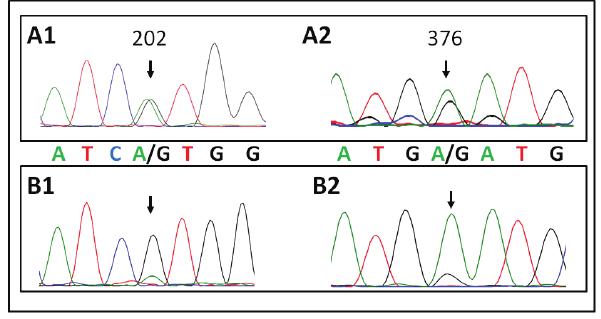
Figure 2. Patient CHOP 277.01. is heterozygous for G6PD B/A- and the B allele is predominantly expressed. A1 and A2 shows sequencing of genomic DNA around the 202 G->A and the 376 A->G mutation that lead to Val68Met and Asn126Asp changes in G6PD, respectively. Figures B1 and B2 show the cDNA sequence of the exact same mutations in the peripheral blood of the patient. The WT (B) allele is expressed in the majority of